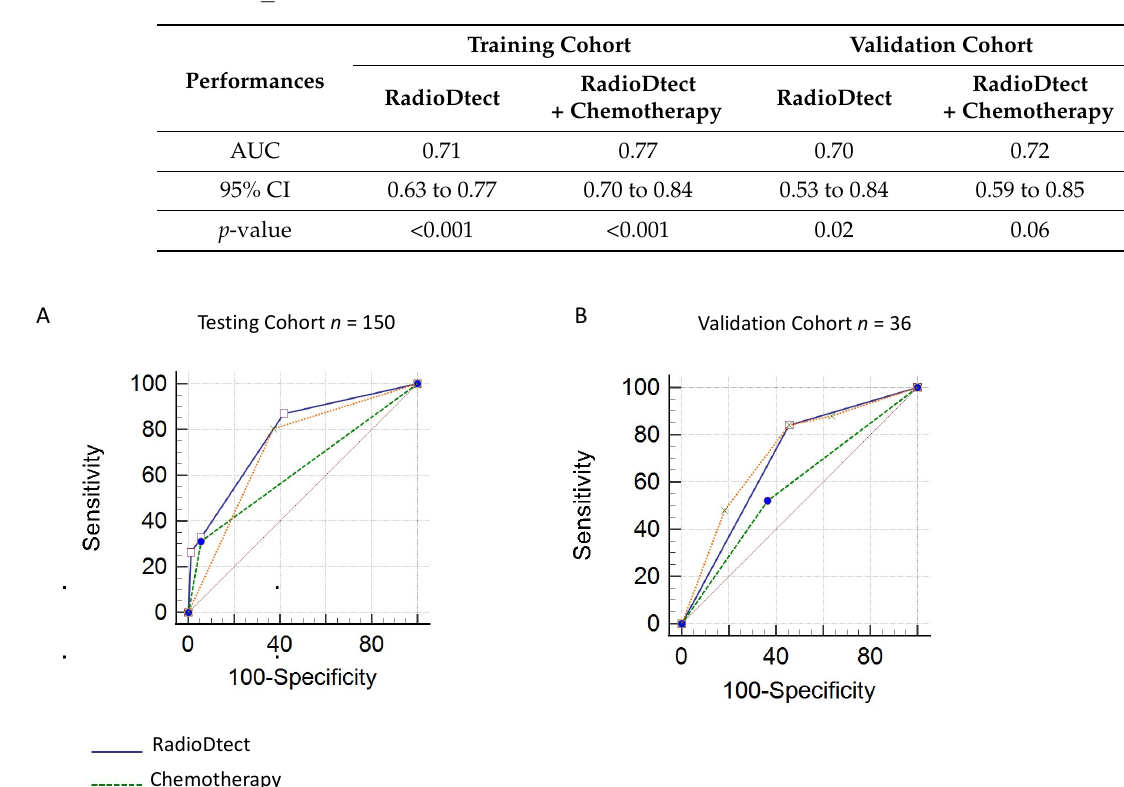
Figure 2. Prediction results and performances of the RadioDtect ® assay of the 36 HNSCC patients. ( a ) ROC analysis was performed on pATM ELISA results and a Wilcoxon rank sum test was also applied to compare RR and RS groups ( p = 0.02). ( b ) Confusion matrix results for the prediction from the pATM data.